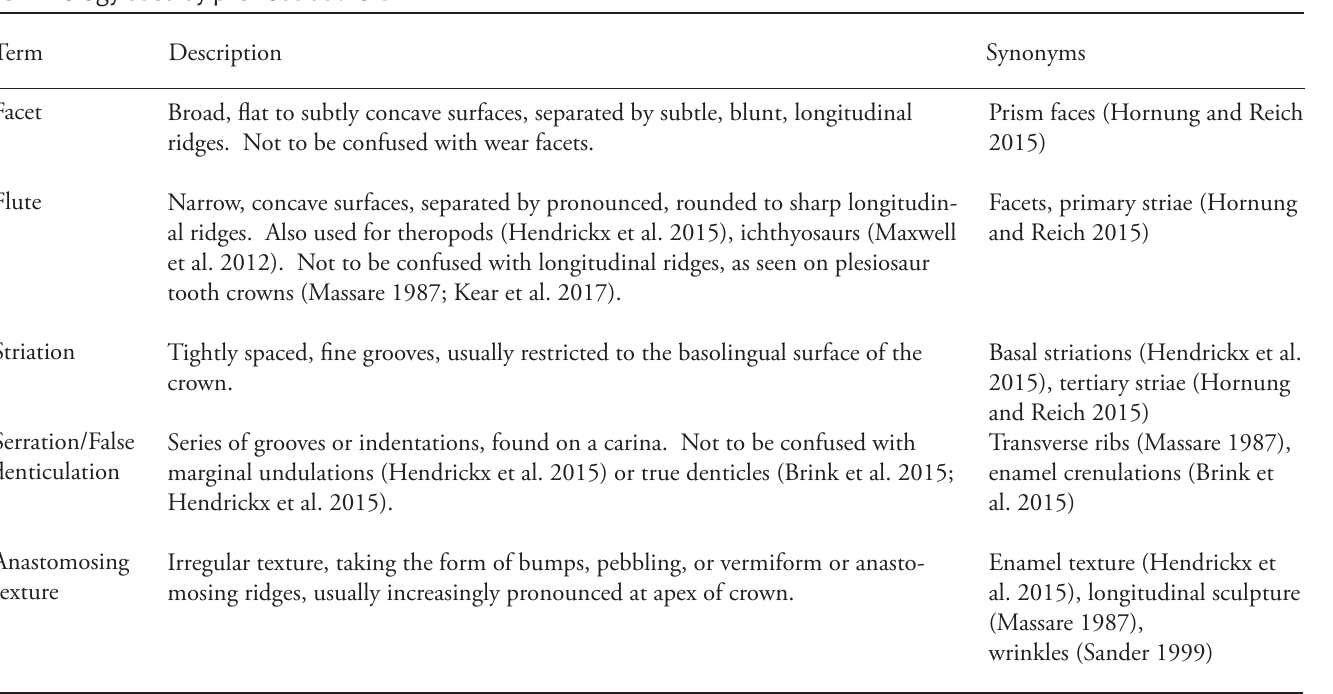
Table 1. Descriptions of the five types of tooth crown surface ornamentation discussed in this study, along with synonymous terminology used by previous